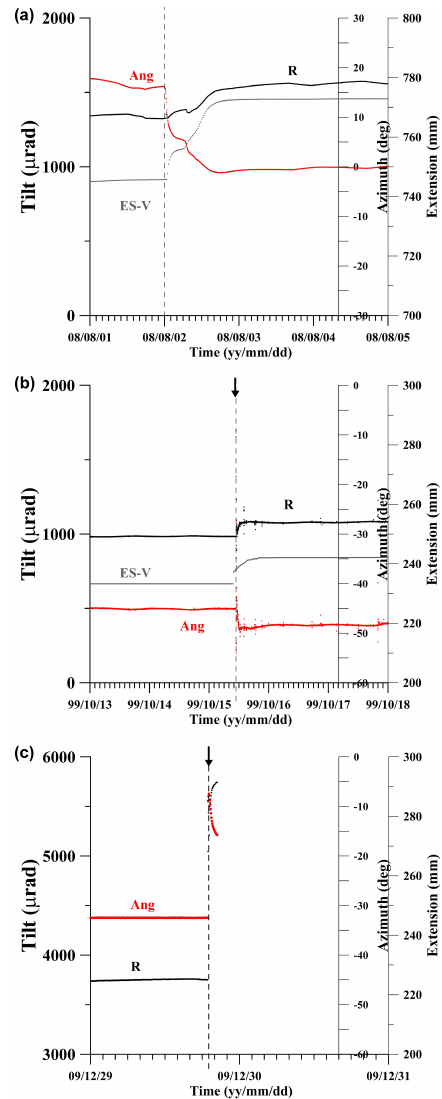
Figure 3. Tilt observations vs. time for episodic slip (a) , triggered slip (b) and coseismic slip (c) . R is the resultant tilt magnitude in the azimuth direction Ang. R is referred to the left axes, while az- imuth Ang is referred to the right axes. Extension ES-V is shown for the period when the creepmeter was working. The vertical ar- row indicates the M = 7.2 1999 hector Mine earthquake (b) and the M = 5.8, 2009 earthquake (c)